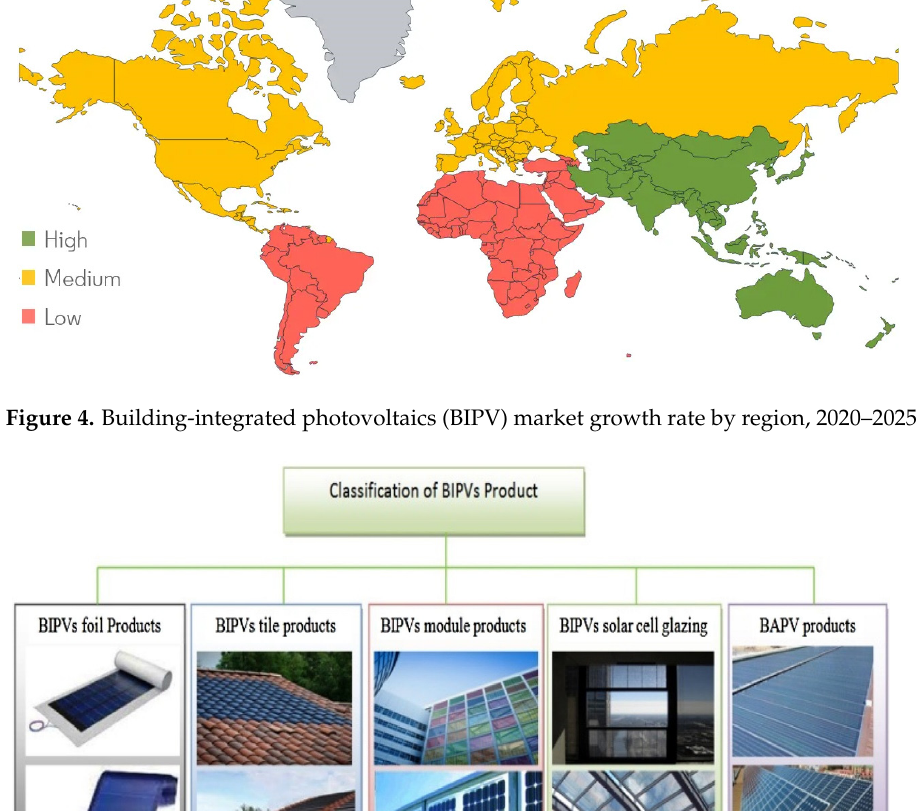
Figure 4. Building-integrated photovoltaics (BIPV) market growth rate by region, 2020–2025 [16].